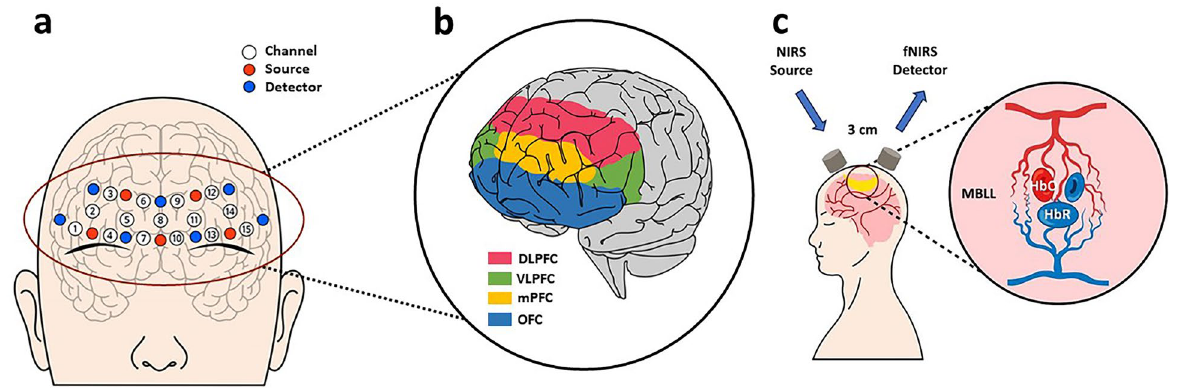
Figure. 1. Schematic channel location and measurement principle of fNIRS device: ( a ) indicates the location of fNIRS channels by attaching them to the participants’ forehead. Based on this channel location, the regions of interest (ROI) related to impulsiveness were set as shown in ( b ). ( c ) Shows the measurement principle by fNIRS. We can obtain optical density signals within banana-shaped pathways from detectors. The measured optical density signals are converted into the concentration changes of oxygenated (∆HbO) and deoxygenated (∆HbR) hemoglobin through the modified Beer-Lambert